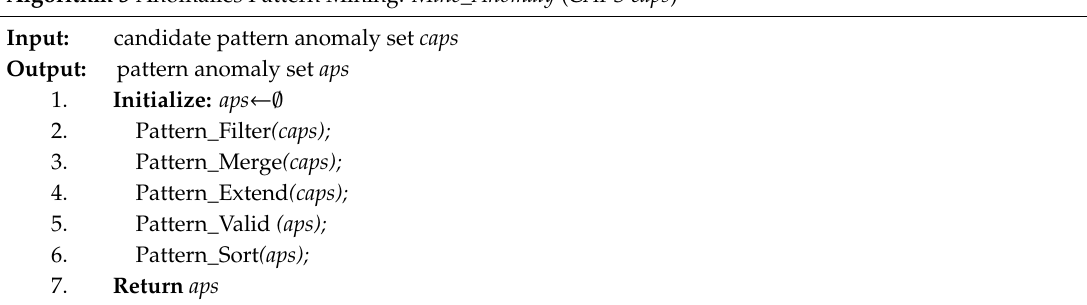
Algorithm 3 Anomalies Pattern Mining. Mine_Anomaly ( CAPS caps